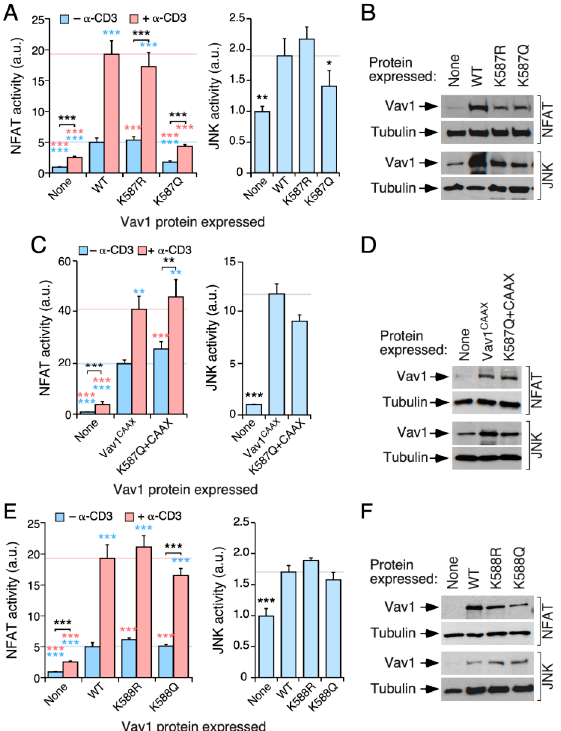
Figure 4. The acetylation of the Lys 587 residue blocks the activation of NFAT by Vav1. ( A , C , E ) Activation of NFAT ( A , C , E ; left panels) and JNK ( A , C , E ; right panels) by indicated Vav1 proteins in